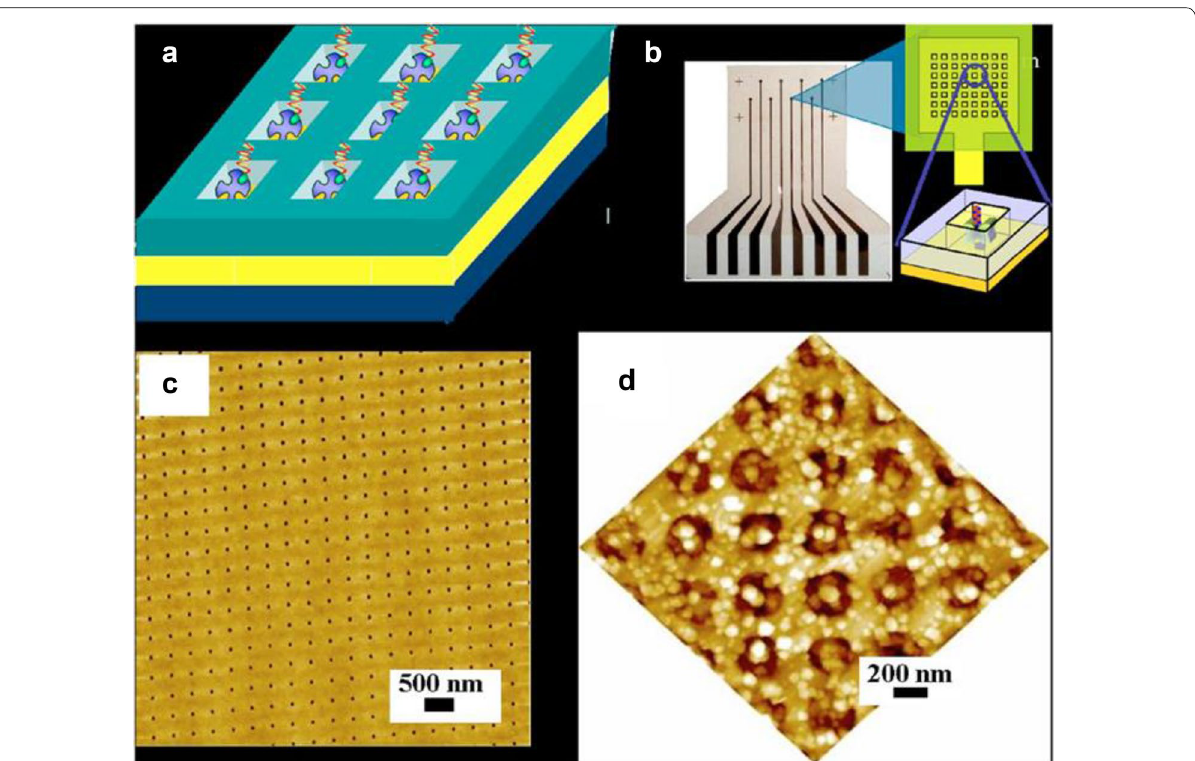
Fig. 1 a Schematic diagram of the ONW array geometry on a gold electrode designed to minimize the unwanted, nonspecific binding or aggrega- tion of biomaterials. b A well-oriented nanowell (ONW) array electrode composed of eight Au pads. The Au electrode on each pad was covered with a resist layer, i.e., a blocking layer. c An AFM image of an ONW array with a 200 200 probe grid on a gold electrode 800 μm in diameter. In × fabricating the ONW array electrode, a 100 100 nm 2 well was generated on the resist surface at 500 nm intervals using nanofabrication technol- × ogy. d An AFM image of probe ssDNA immobilized by streptavidin-biotin on an ONW array. Although there are also bright spots on the resist layer, these DNA/streptavidin complexes do not contribute to the electrochemical